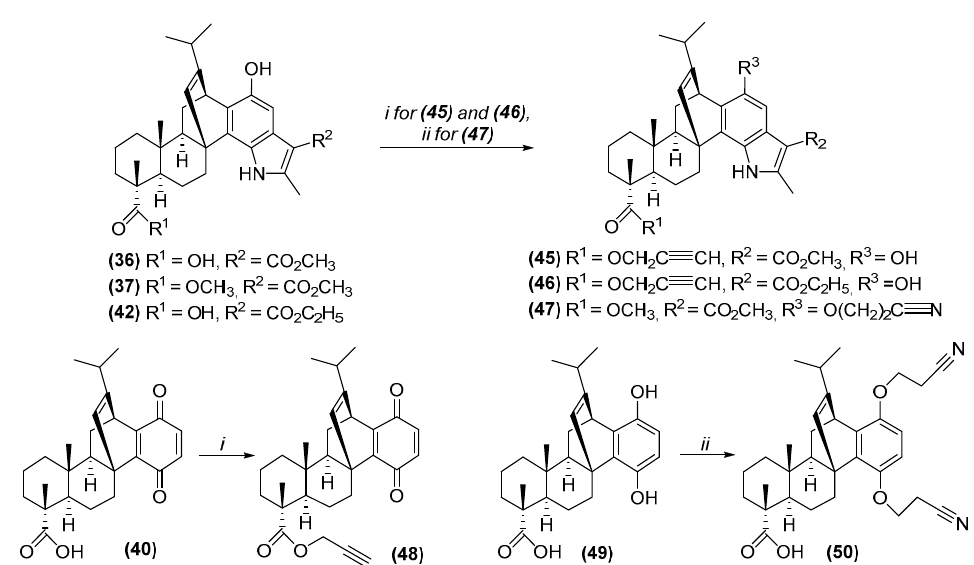
Scheme 2. Synthesis of propargyl 45 , 46 , 48 and cyanoethyloxy 47 , 50 quinopimaric